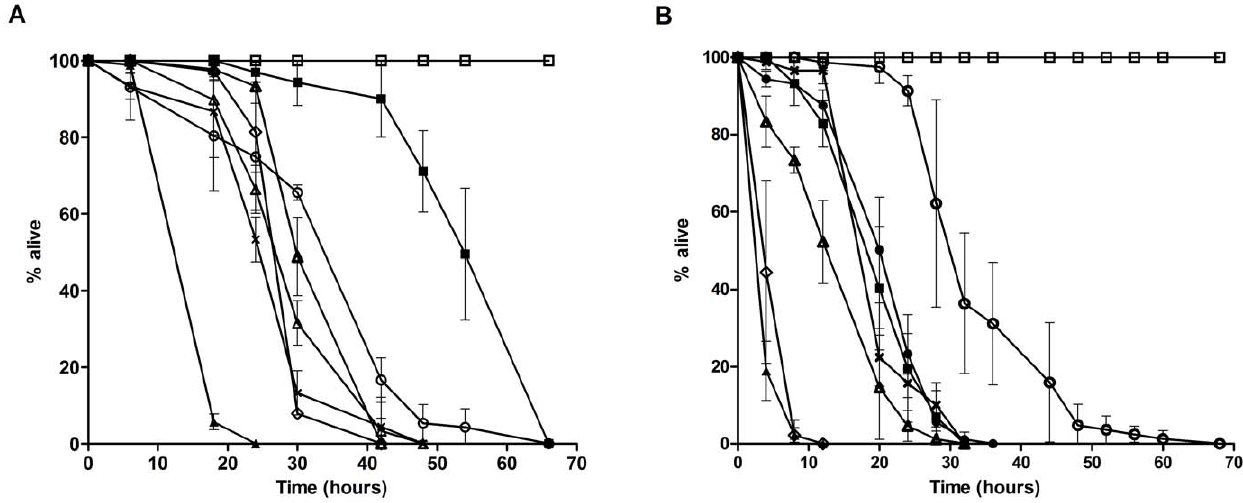
Figure 2. B.pseudomallei diffusible toxins alone are not sufficient to mediate full killing effect. (A and B) One-day old Glp worms were transferred to individual B. pseudomallei free culture, Human PMC2000 (open diamonds), Human D286 (open triangles), Human R15 (crosses), Human H10 (open circles), Rabbit 2514 (closed squares), Sheep 4523 (closed triangles), Ostrich 9166 (closed circles) and E. coli OP50 (open squares). Graph shows the mean 6 SD of three replicates (30 worms/replicate) from a representative of 3 independent experiments. (A) Conditioned NG medium with grown B. pseudomallei on a 0.22 m m pore size sterilized nitrocellulose filter. (B) Filtered culture supernatant of B. pseudomallei supplemented with S-basal medium.